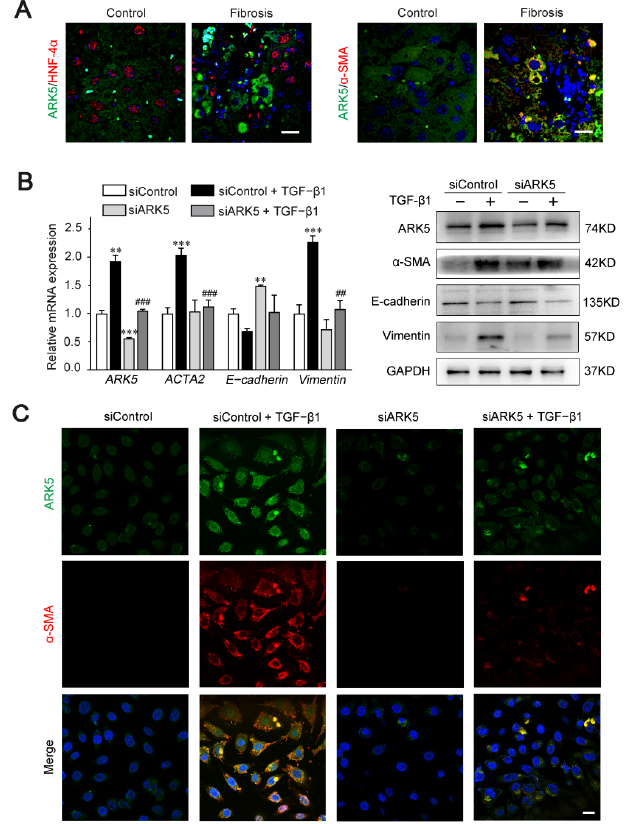
Figure 6. ARK5 expression was associated with hepatocyte EMT. ( A ) Immunofluorescence